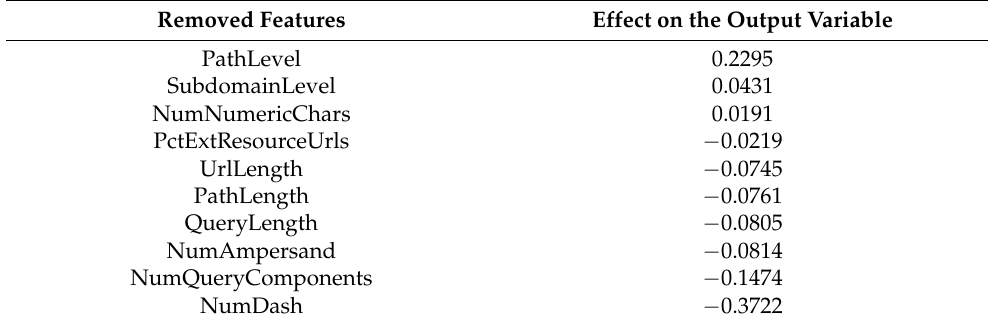
Table 13. List of removed features using Spearman and their effect on the output variable on dataset 1.